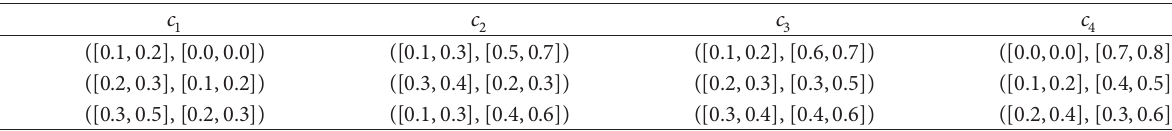
Table 1: The interval-valued intuitionistic fuzzy decision matrix